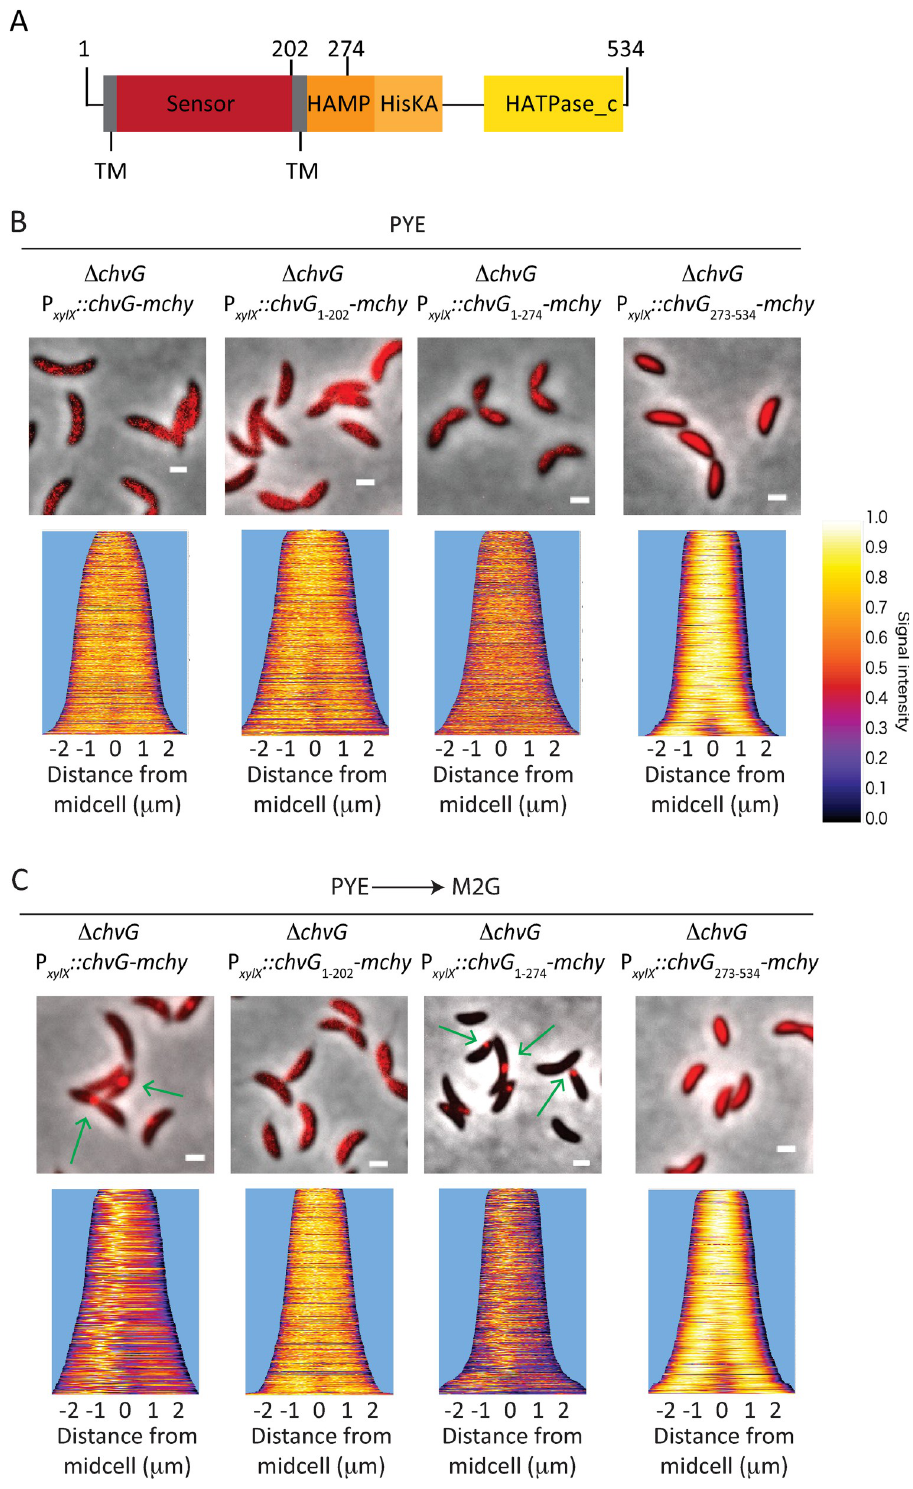
Fig 7. The N-terminal periplasmic sensor domain of ChvG is required for patchy-spotty localisation pattern and mid-cell relocation. (A) Conserved domains in the HK ChvG and position of the amino acids defining the truncated proteins. (B-C) Localisation of ChvG WT and truncated versions in cells grown in PYE and imaged on PYE agarose pads (B) or in cells grown in PYE, washed in M2G and imaged on M2G agarose pads (PYE ➔ M2G) (C).